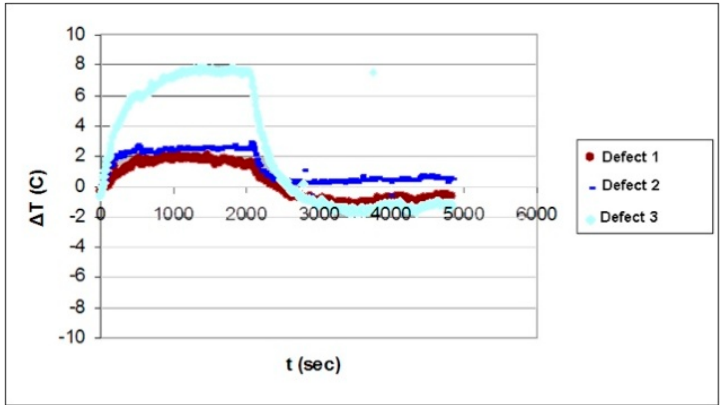
Figure 7. Temperature—Time plot from the experimental work.